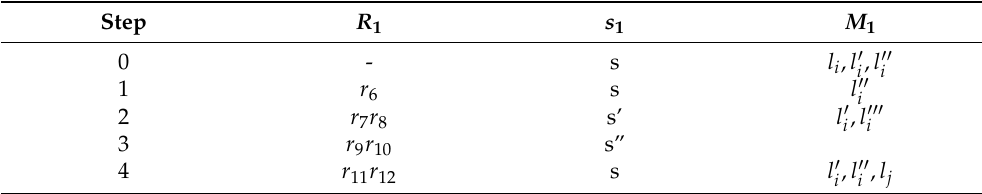
Table 5. The application of rules in R 1 , the evolution of channel states s 1 , and the rewriting of multisets M 1 in membrane 1. During the simulation of a SUB instruction l i :( SUB ( r ) , l j , l k ) with register r not empty.